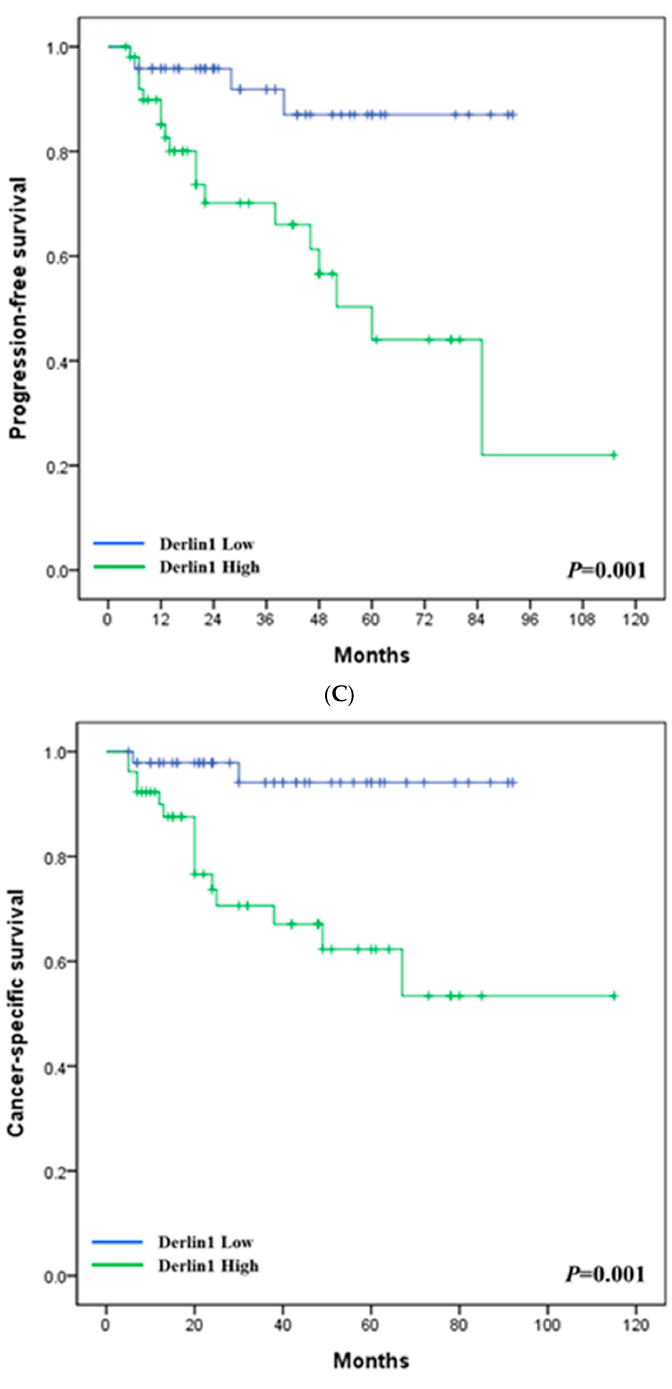
Figure 1. Derlin-1 is overexpressed in UTUC tissues and is associated with survival of patients. ( A ) The staining intensity of Derlin-1 of UTUC samples was examined by immunohistochemistry. The range of Derlin-1 expression partitioned into negative control, low and high. ( B ) Kaplan-Meier survival curves for bladder recurrence-free survival of patients of UTUC. ( C ) Kaplan-Meier survival curves for progression-free survival of patients of UTUC. ( D ) Kaplan-Meier survival curves for cancer-specific survival of patients of UTUC. Scale bar, 50 µ